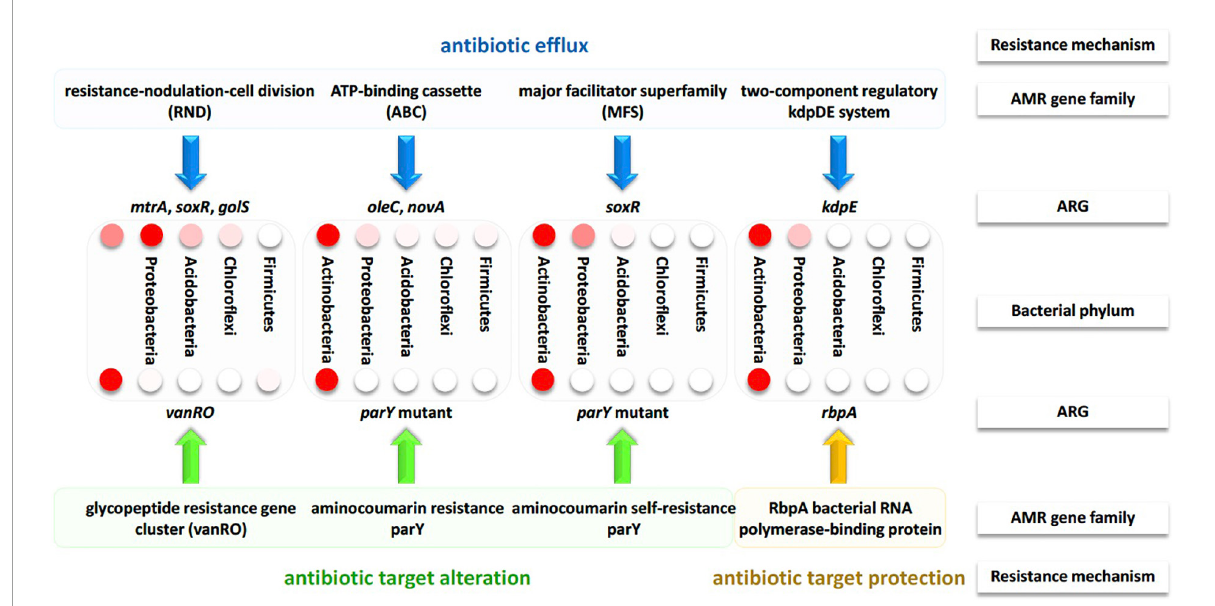
FIGURE6 Summary of the resistance mechanisms along with the participating AMR gene families and their ARGs of bacterial phyla across soil microbiomes surrounding Moringa oleifera. Different intensities of the red color of the circles refer to the level of differential abundance in bacterial